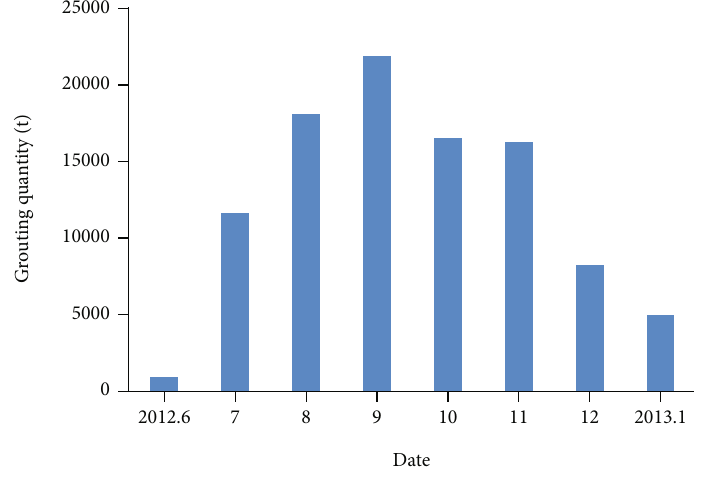
Figure 9: Quantity of fl y ash injected per month.